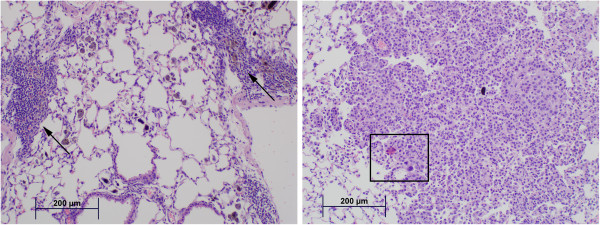
Photomicrographs of lung tissue from MCA-treated mice. Representative photomicrographs were captured at 30 weeks after MCA-initiation and show presence of lymphoid infiltrates (i.e., inflammatory cell infiltrates consisting of peribronchial/perivascular associated lymphocytes, macrophages, and plasma cells) and welding PM (arrows) in the MCA/low GMA-SS group (left panel). An area of malignant transformation (rectangle)—larger cells with irregular nuclei and associations—in the MCA/high GMA-SS group (right panel).